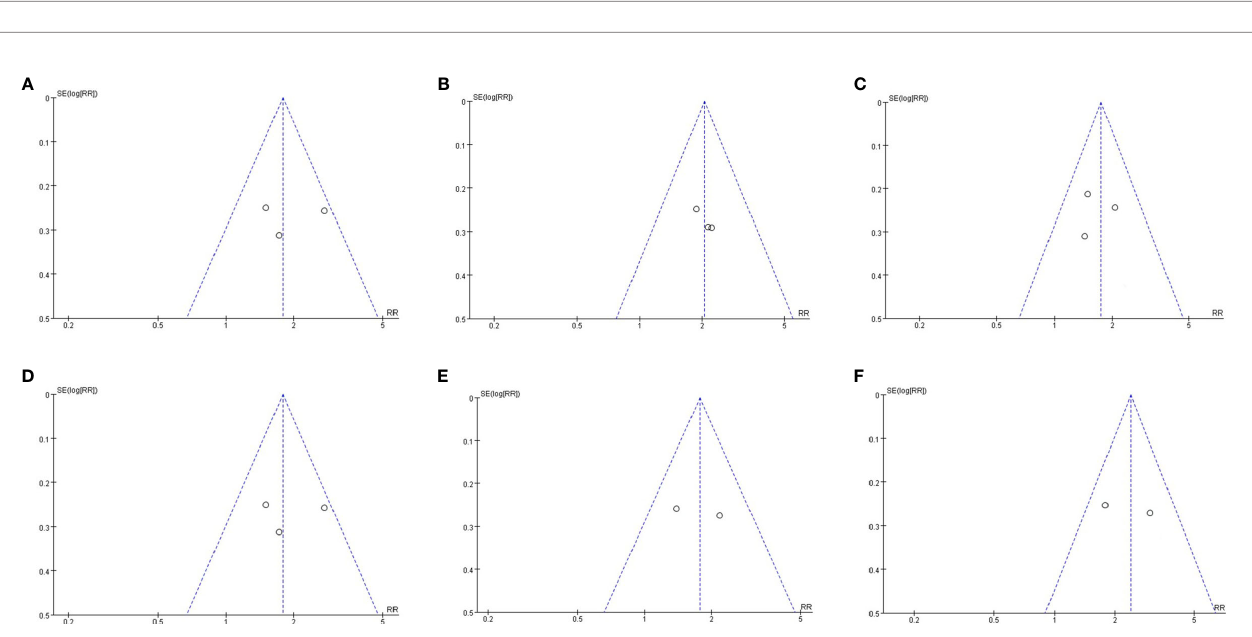
FIGURE 6 | Effects of pioglitazone on the risk of adverse events in patients with pre-diabetes or T2DM combined with NAFLD (A) ; Effects of pioglitazone on the risk of discontinuations in patients with pre-diabetes or T2DM combined with NAFLD (B) ; Effects of pioglitazone on the risk of Serious Adverse Events in patients with pre-diabetes or T2DM combined with NAFLD (C) .